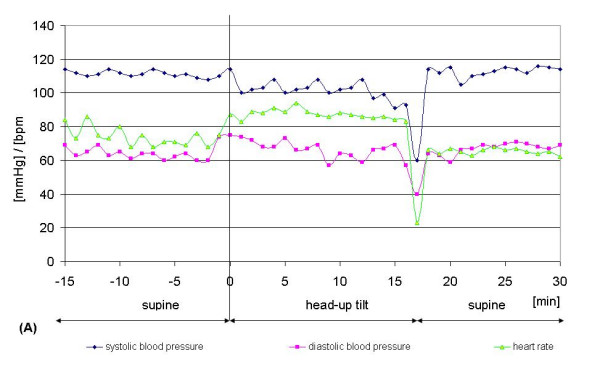
Typical recordings illustrating a subject with syncope. RF = M. rectus femoris, BF = M. biceps femoris, TA = M. tibialis anterior, GM = M. gastrocnemius